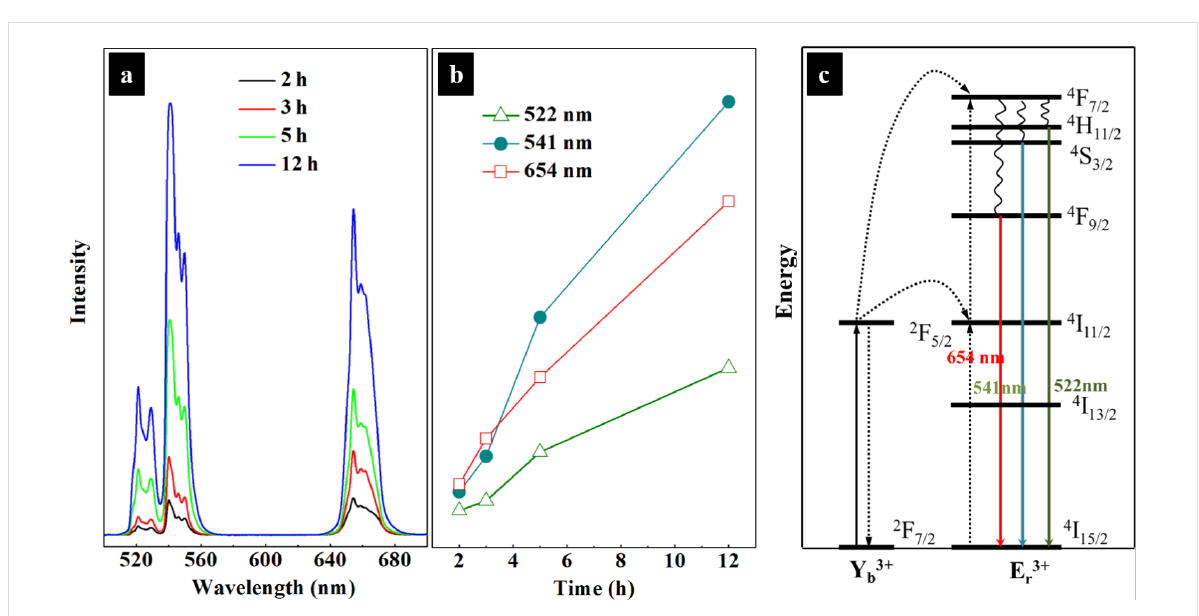
Figure 2: (a) Photoluminescence spectra of NaYF 4 :Yb 3+ /Er 3+ samples under 980 nm laser illumination with a power of 60 mW; (b) peak intensities at 522, 541, and 654 nm as a function of the reaction time. (c) energy transfer mechanisms for the Yb 3+ –Er 3+ couple under 980 nm laser illumination.